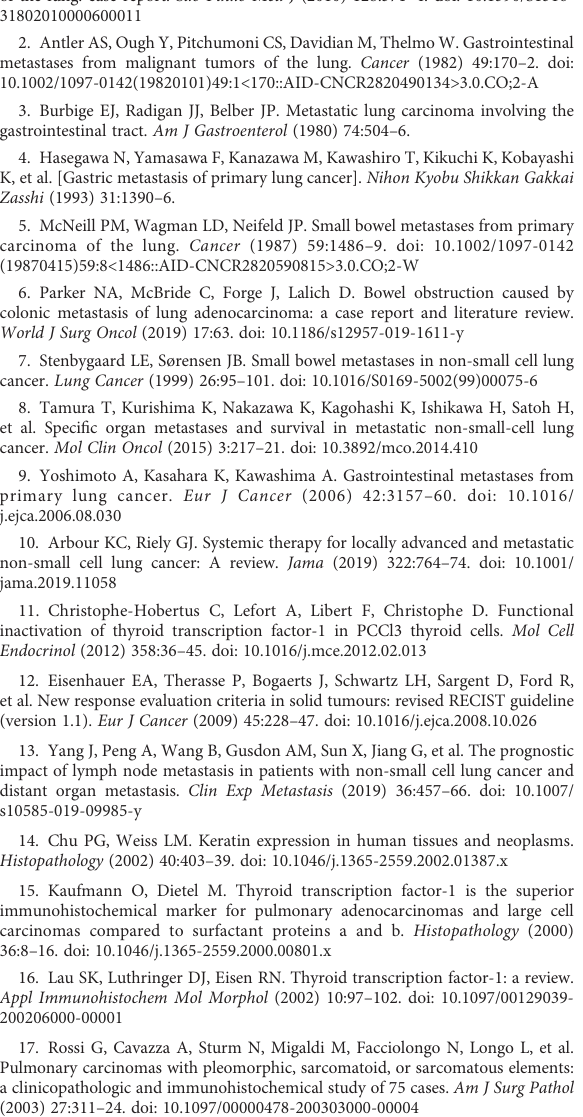
Imaging results in the period between diagnosis and metastasis(red arrow: lung adenocarcinoma). (A) CT image before Camrelizumab+Alimta